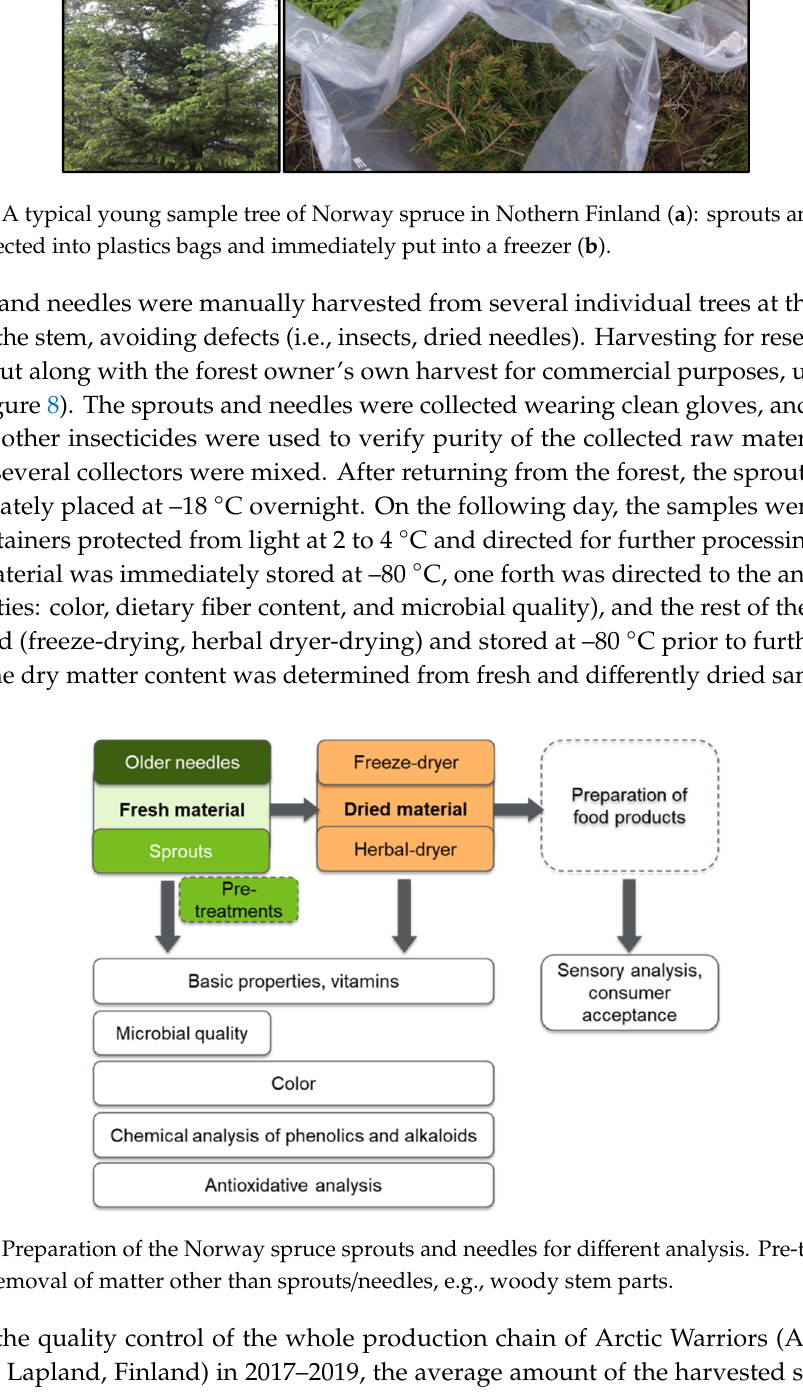
Figure 8. A typical young sample tree of Norway spruce in Nothern Finland ( a ): sprouts and needles were collected into plastics bags and immediately put into a freezer ( b ).